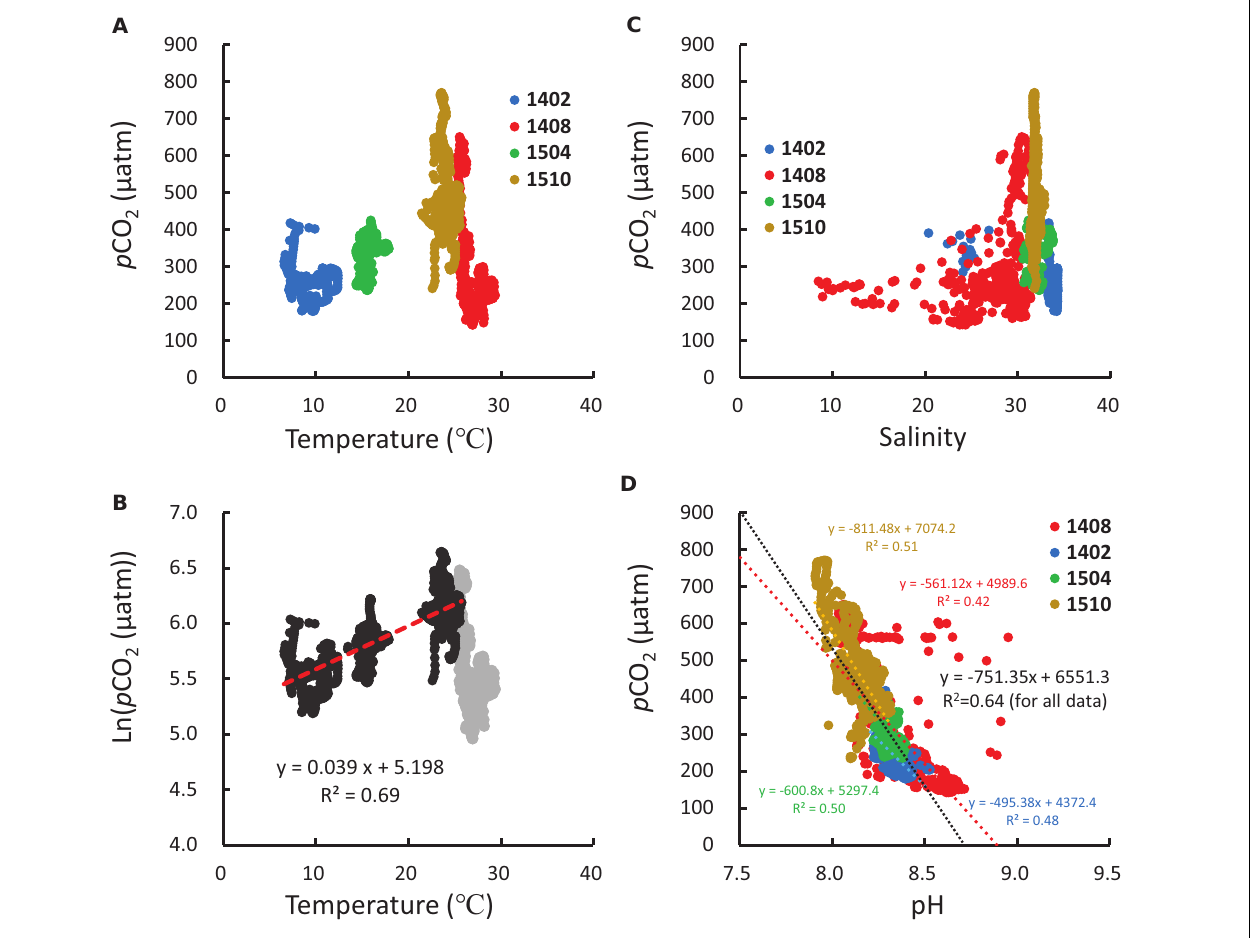
FIGURE 7 | Plots of surface p CO 2 versus temperature (A,B) , salinity (C) , and pH (D) for each survey (dots: blue, Feb. 2014; red, Aug. 2014; green, Apr. 2015; dark yellow, Oct. 2015). In panel (B) , the p CO 2 concentration is expressed as a logarithmic scale and is correlated except for August (gray).